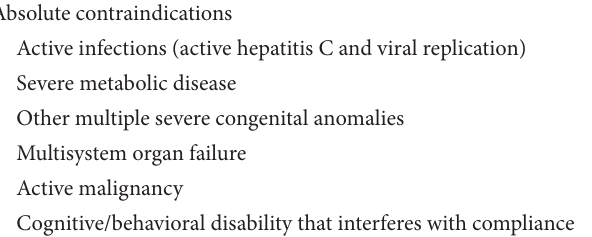
Table 3: Contraindications for heart transplantation in adult con- genital heart disease.